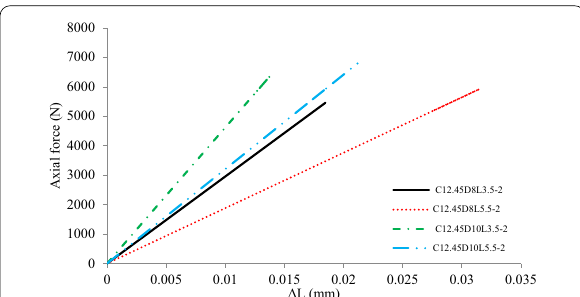
Fig. 11 Sliding force–deformation diagram in C12.45D8L3.5-2 and C12.45D8L5.5-2, and C12.45D10L3.5-2 The comparison between results of slip force revealed that an increment in rebar diameter increases the slip force generated between rebar and concrete. It attrib- (2) utes to the improvement of axial stiffness as shown in Eq. (2), which consequently increases the slip force. The same trend can also be observed in Fig. 11.